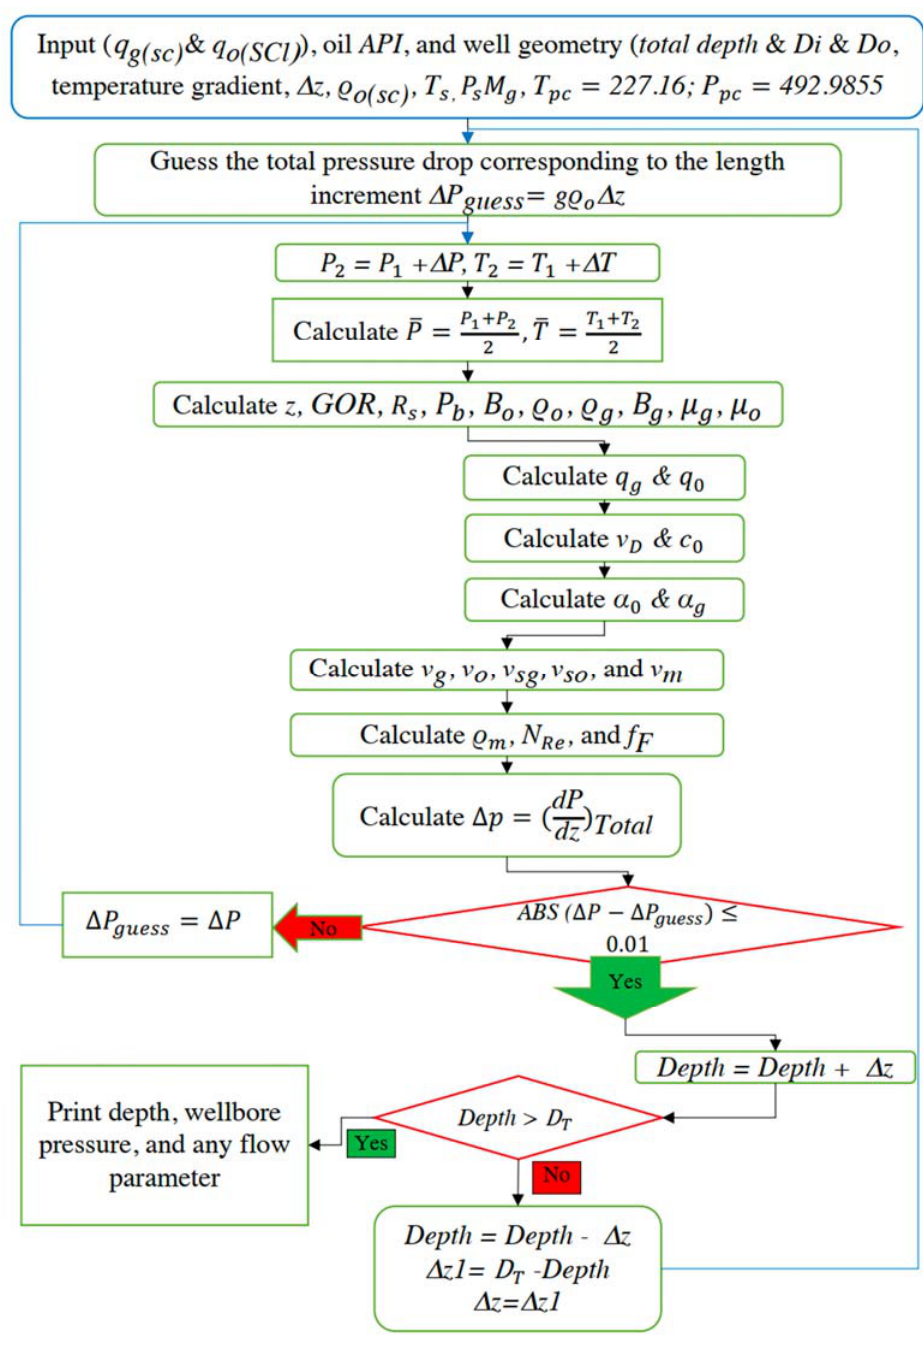
Figure 4. Coding workflow inside MATLAB environment for calculating various PVT properties.